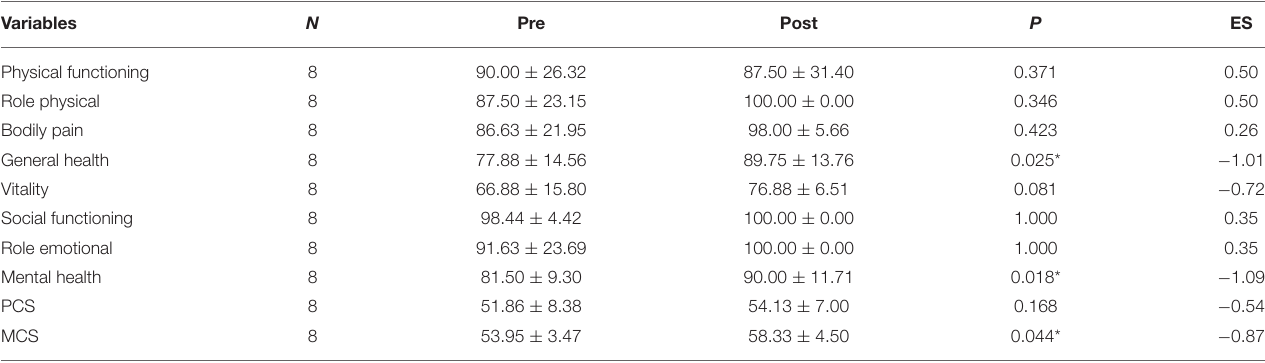
TABLE 5 | Health-related quality of life (SF-36) before and after the home training period.